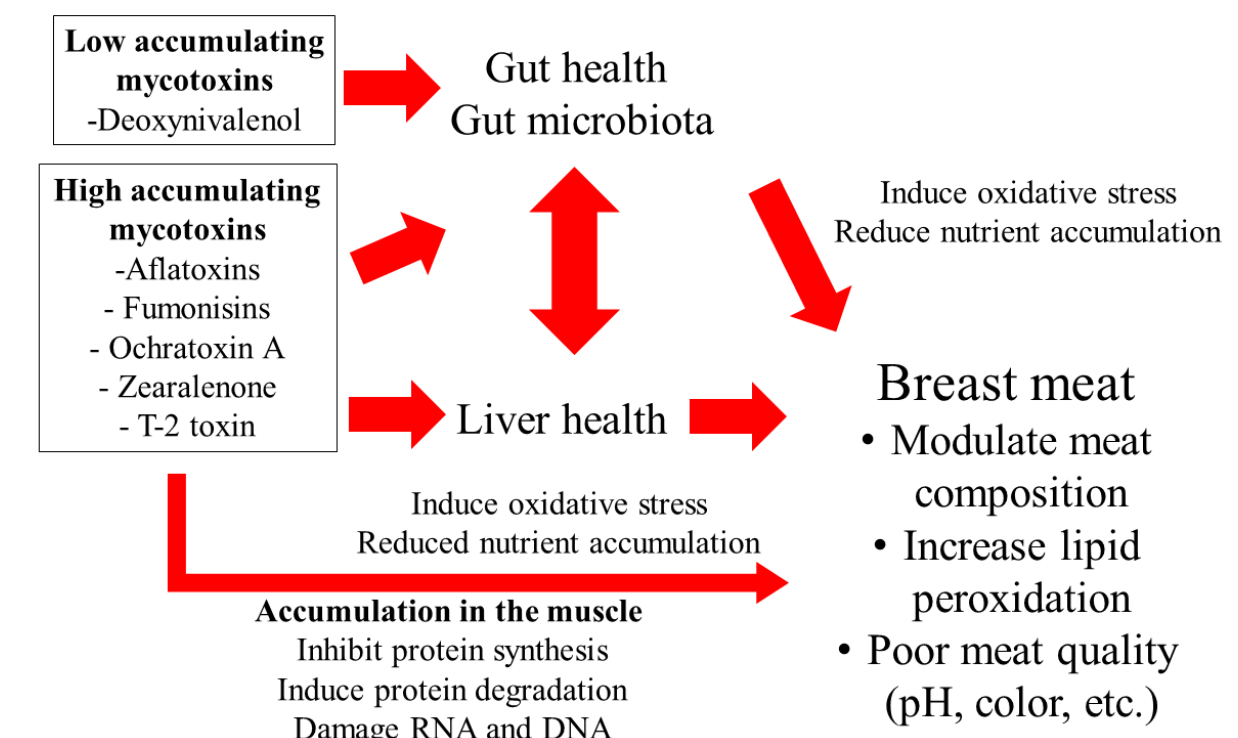
Figure 1. Proposed effects of low- and high- accumulating mycotoxins on the meat quality of broiler chickens. Low-accumulating mycotoxins negatively affect the gut health and gut microbiota of broiler